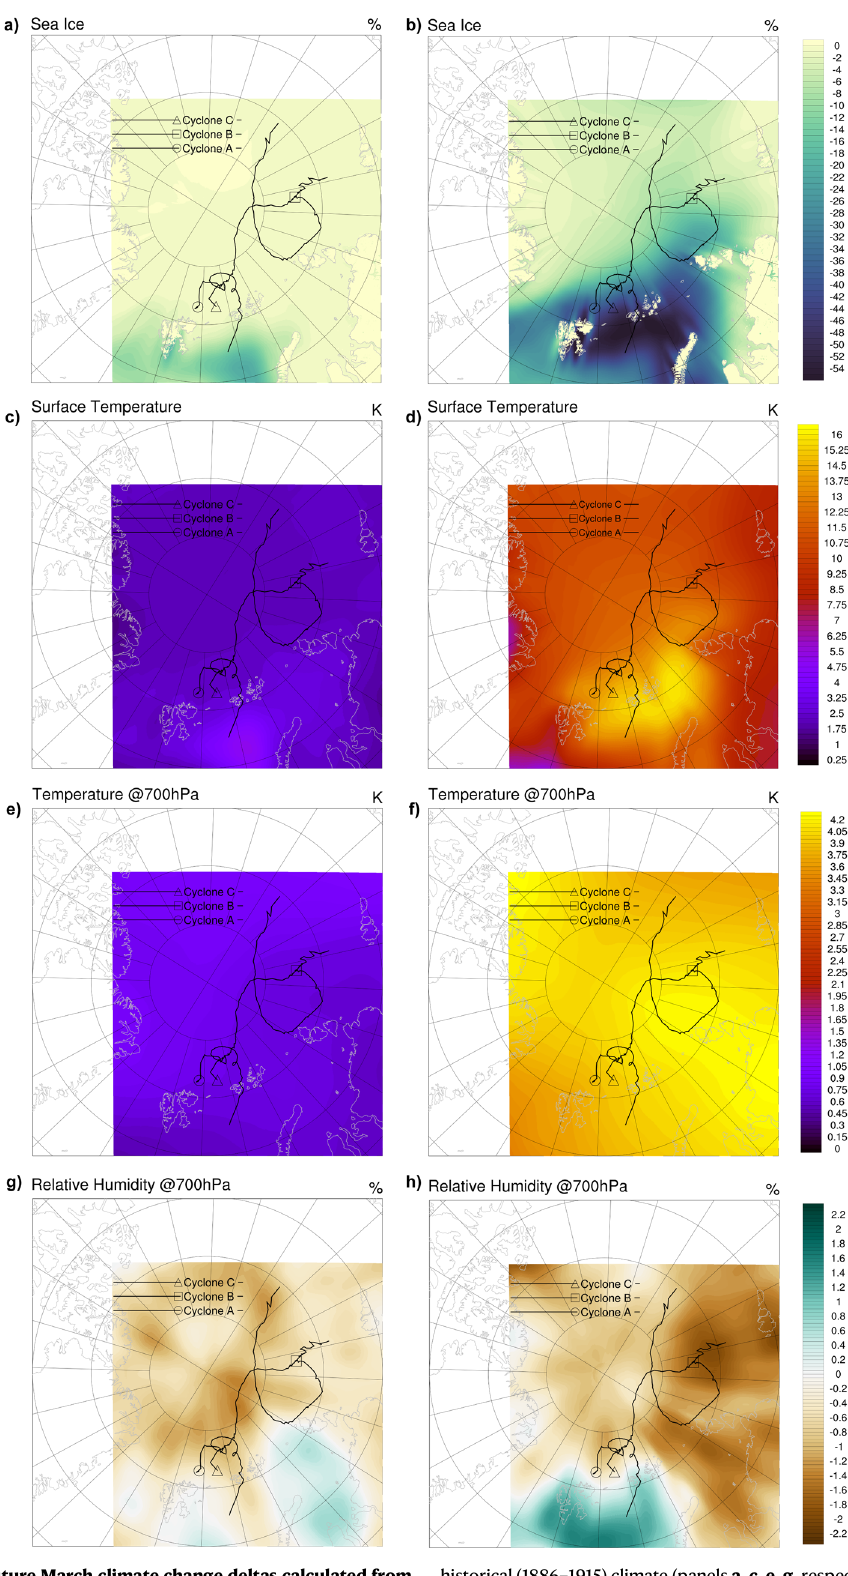
historical(1886 – 1915)climate(panels a , c , e , g ,respectively)andtheaveragefuture (2070 – 2100) minus the average current climate (panels b , d , f , h ). The simulated tracksofcyclonesA – Cinthecurrentclimateareoverlain.Markersshowtheendof the